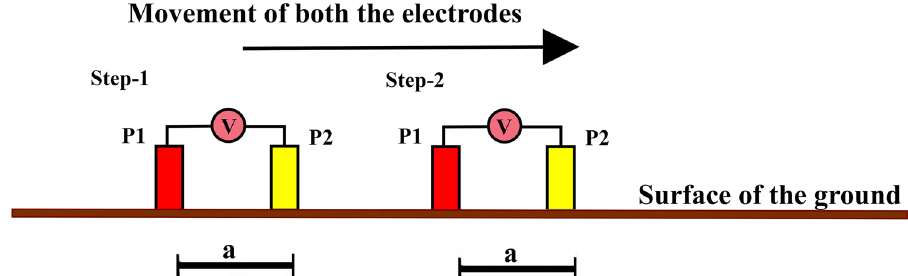
Fig. 2 Self-potential method gradient array